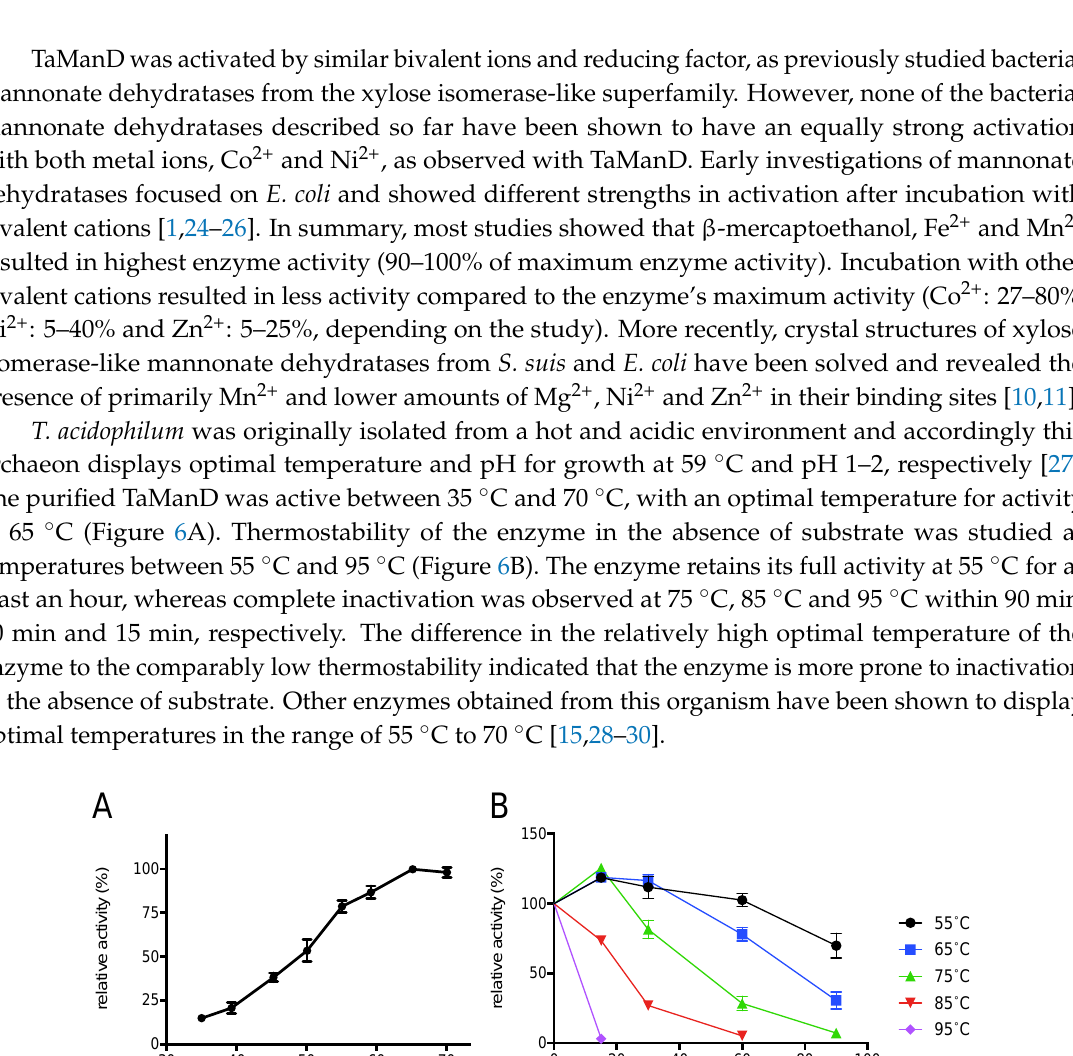
Table 1. TaManD kinetic data with D-mannonate (prepared by hydrolysis with NaOH) and with